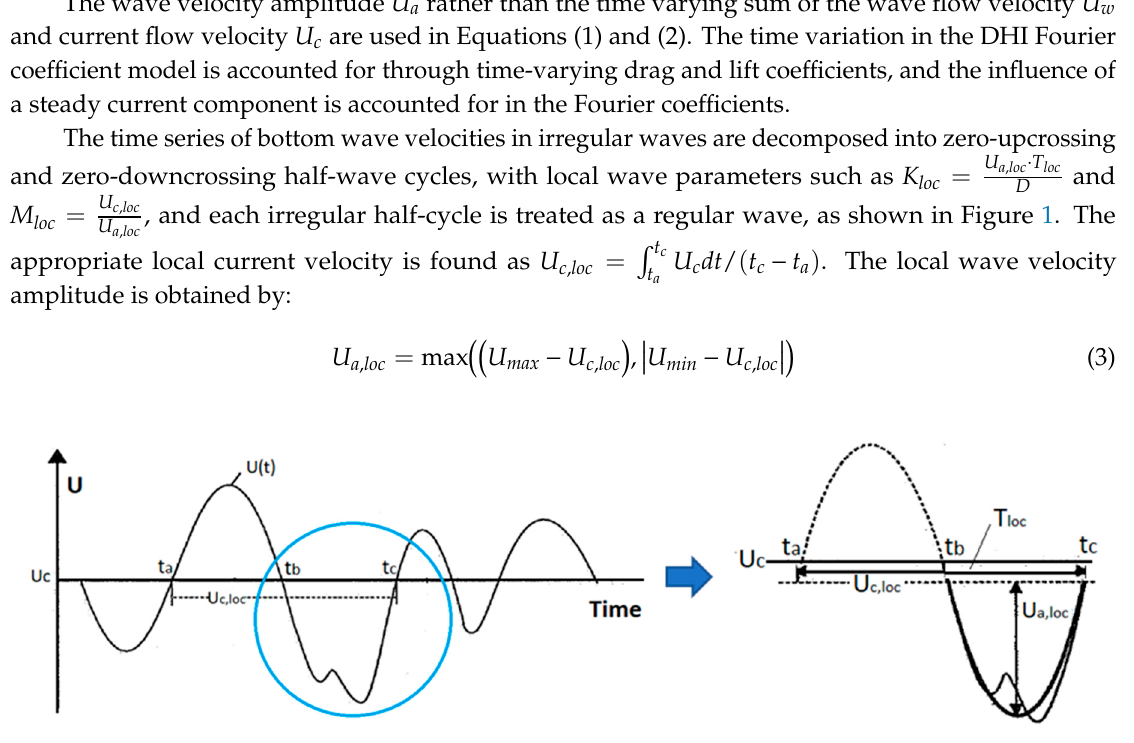
Table 1. Range of experimental